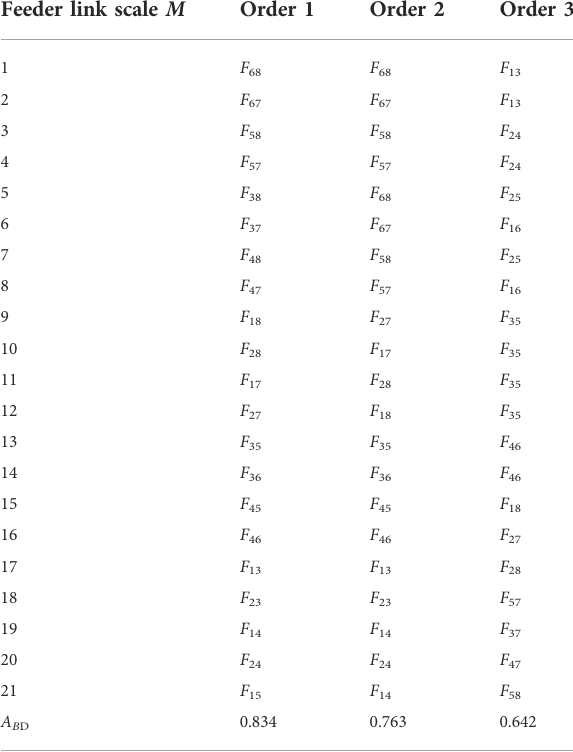
TABLE 1 Construction orders of feeder links of case 4. Feeder link scale M